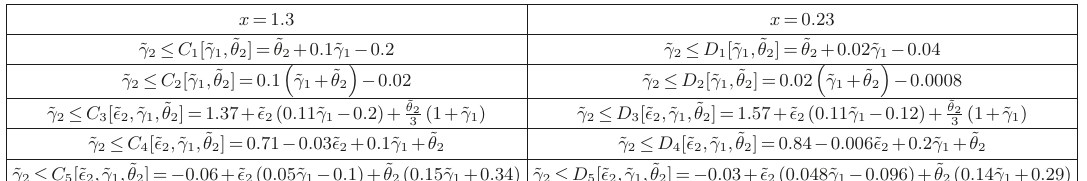
, including the x = 1 . 3 in the left and x = 0 . 23 T 0